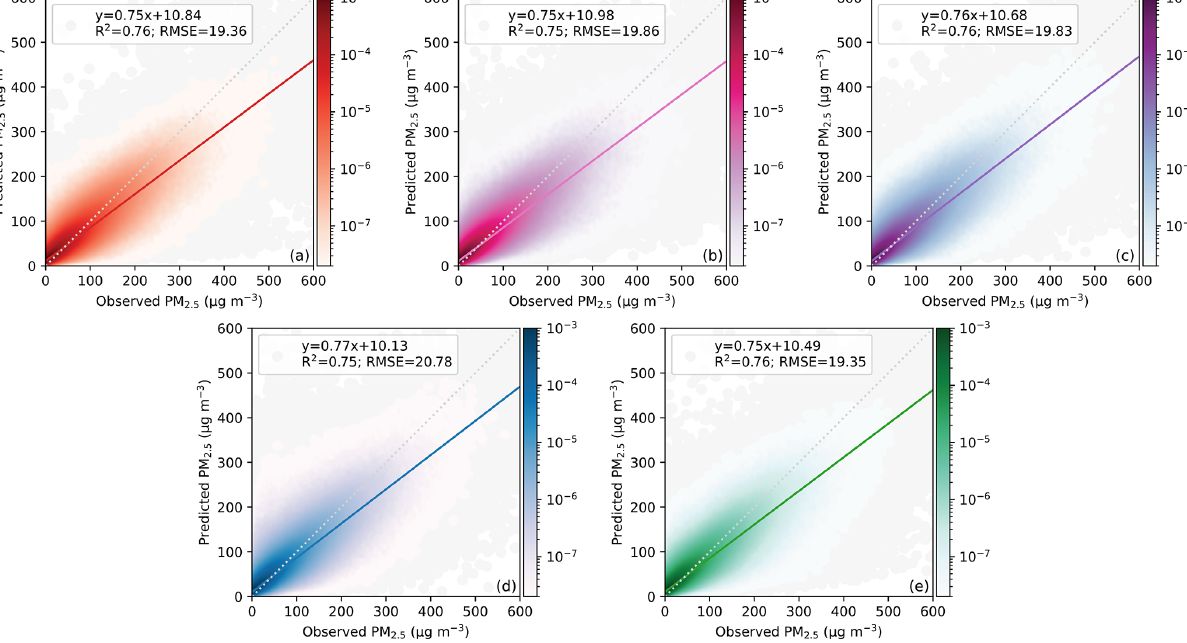
Earth Syst. Sci. Data, 14, 3197–3211,